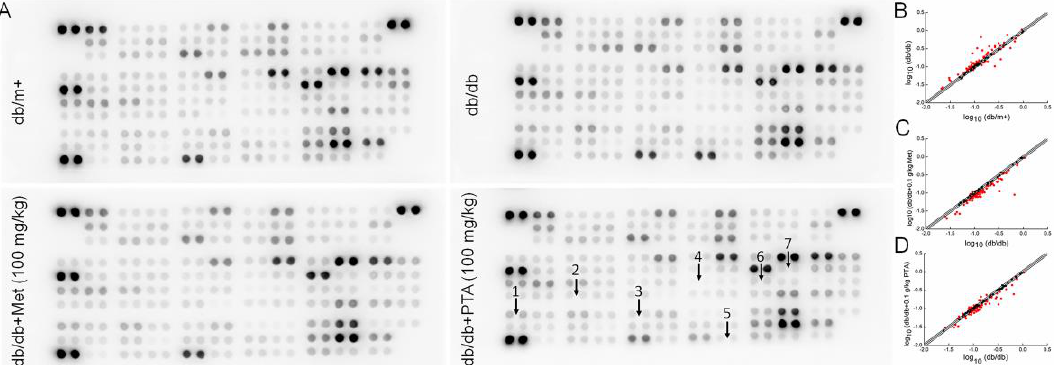
Figure 5. Analysis of inflammatory factors expressed in the kidneys of db / db mice using a Proteome Profiler Mouse XL Cytokine Array. ( A ) The graphical representation of cytokine expressions. ( B – D ) Scatter diagram of 111 different cytokines (n = 3). The relative density represents the ratio of the absolute value and the reference spot value. Red dots indicate factors with a change of > 10%. ( B ) db / db mice vs. db / m + mice, ( C ) db / db mice vs. Met (metformin)-treated db / db mice and ( D ) db / db mice vs. PTA-treated db / db mice. 1, leptin (LEP); 2, interlekin-12 (IL-12); 3, macrophage colony-stimulating factor (M-CSF); 4, IL-2; 5, tumor necrosis factor- α (TNF- α ); 6, IL-4; and 7, interferon- γ (IFN- γ ). Table 1. Significantly changed inflammatory factors that were regulated by Met and PTA; authenticated by ELISA.